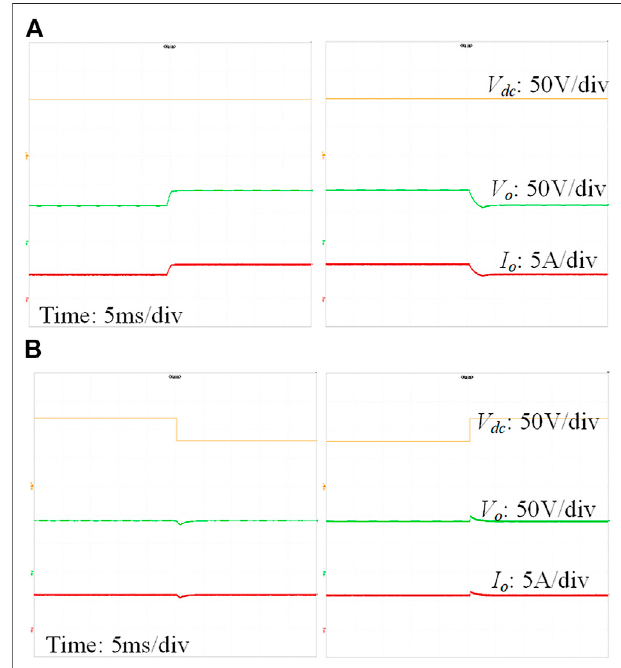
FIGURE11| DynamicwaveformsofthesingleDABconverter withSPS: (A) when the load steps between half load and full load; (B) when the input voltage steps between 80% and 120% rated voltage.